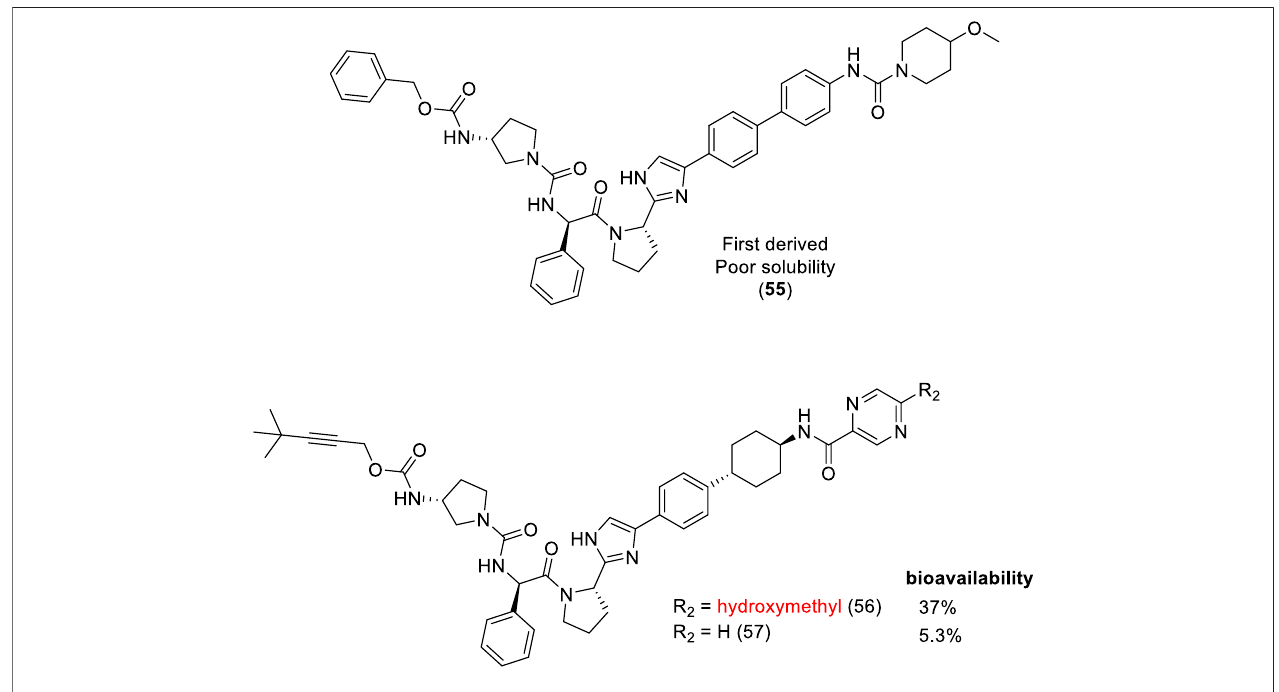
FIGURE 5 | Hydroxymethyl derivatives as HCV NS5A inhibitors ( 56